Question: Summarize what this figure shows in one sentence.
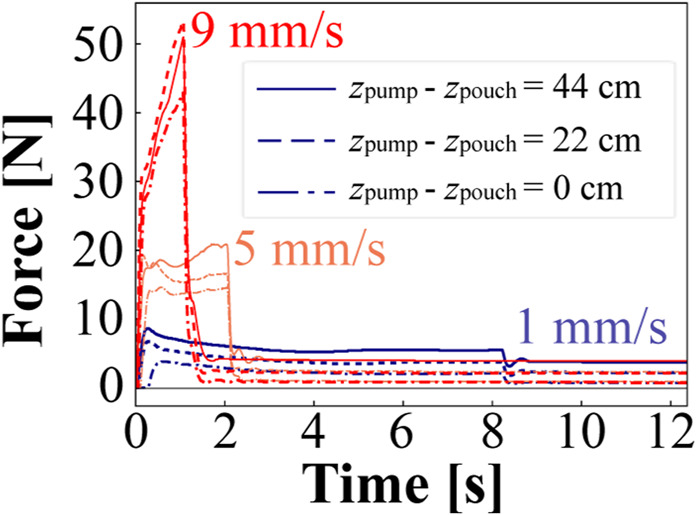
Answer: Time course of contact force on pouch without endoskeleton.